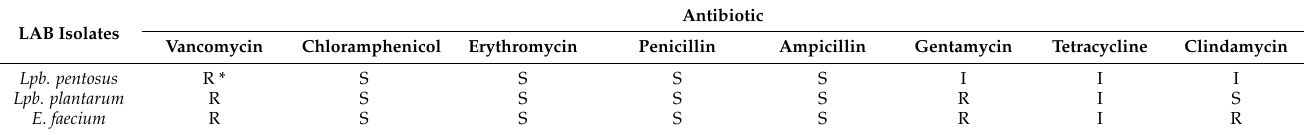
Table 1. Antibiotic resistance of selected LAB isolates against various